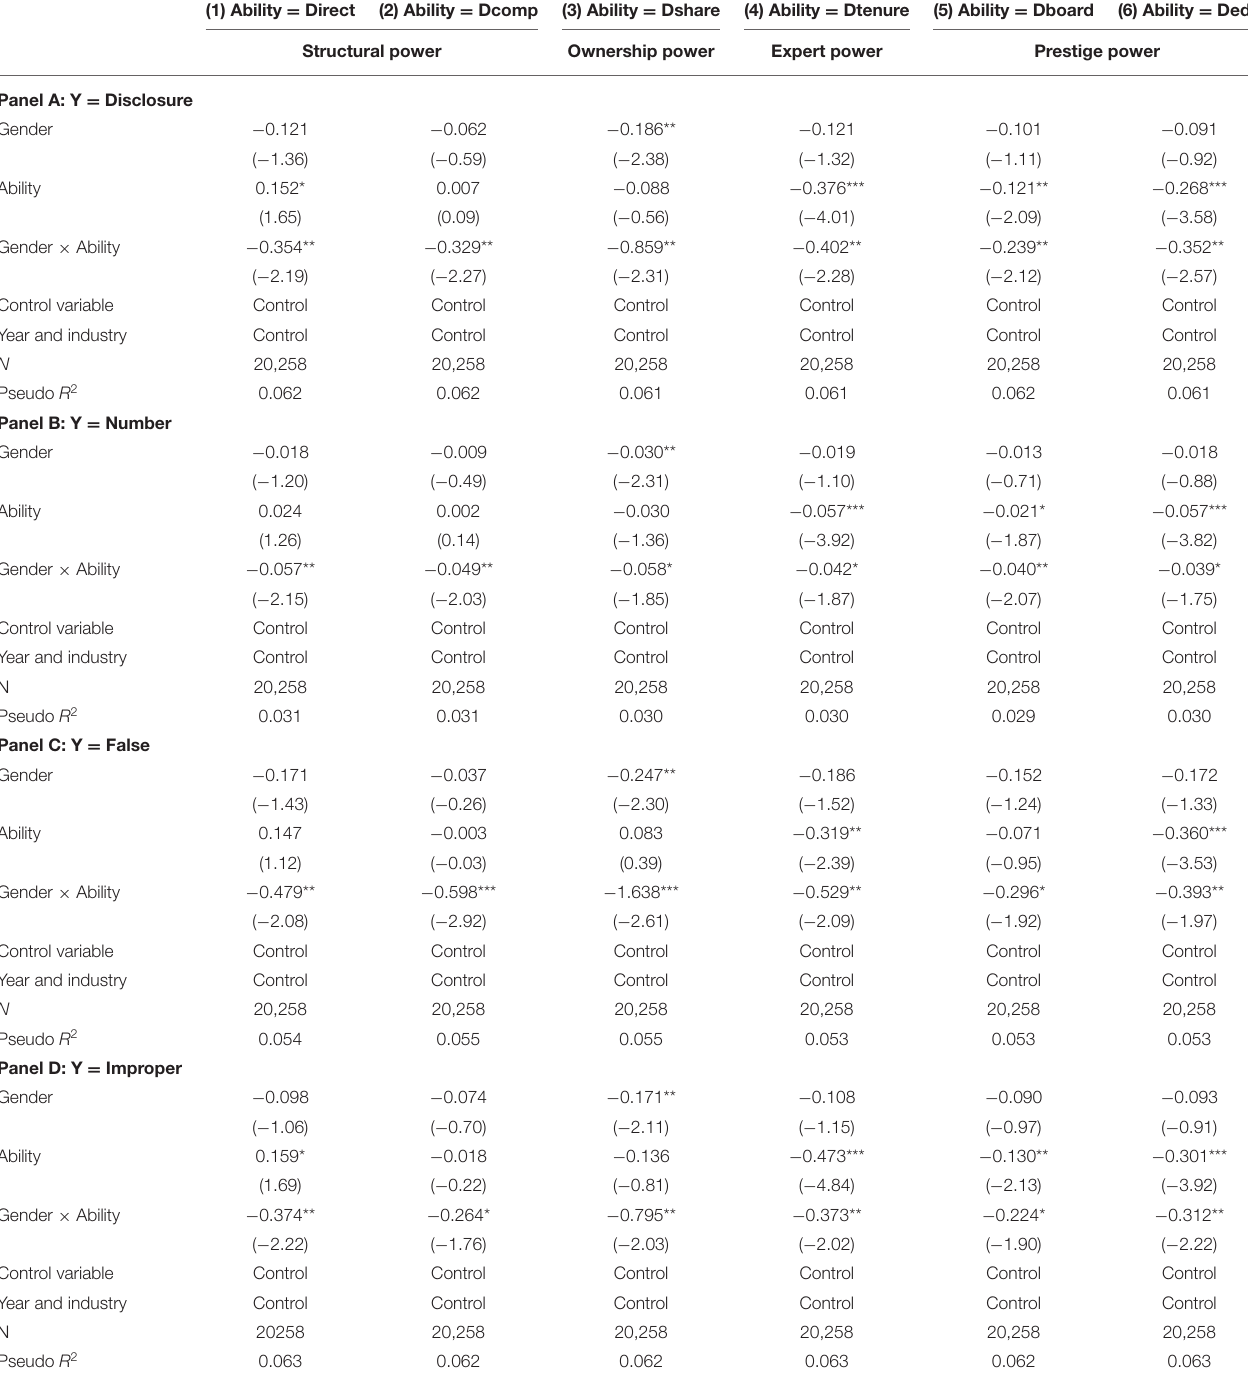
TABLE 3 | CFO power, gender, and information disclosure violations. (1) Ability = Direct (2) Ability = Dcomp (3) Ability = Dshare (4) Ability = Dtenure (5) Ability = Dboard (6) Ability = Dedu Structural power Ownership power Expert power Prestige